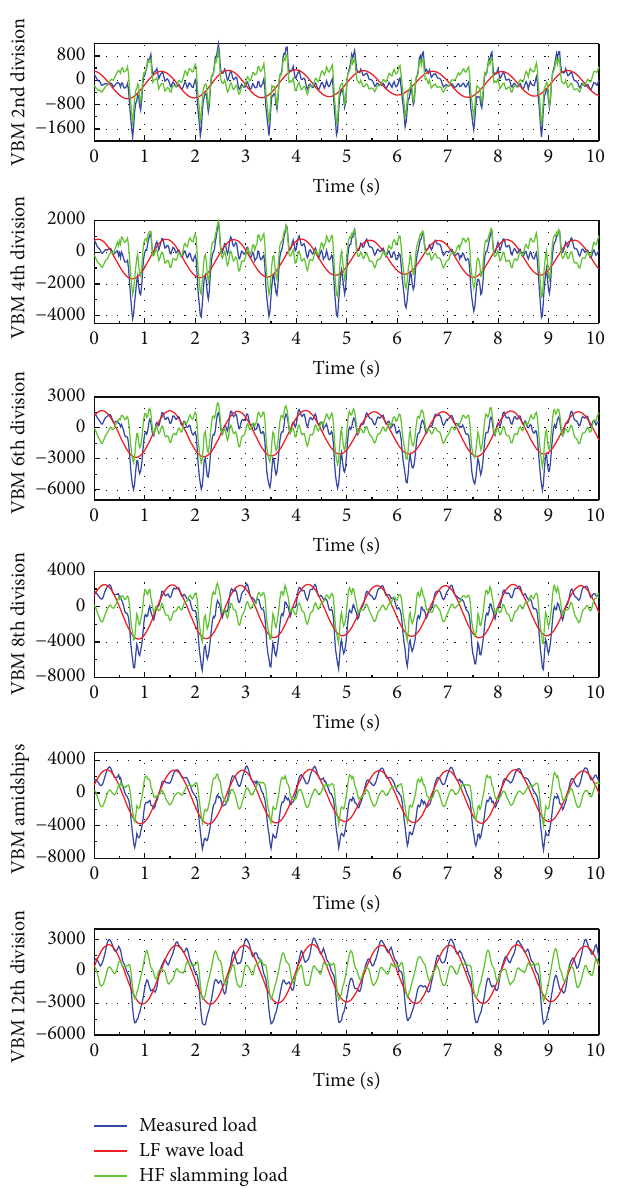
Figure 7: Time histories of VBM components at different divisions (scheme 1).